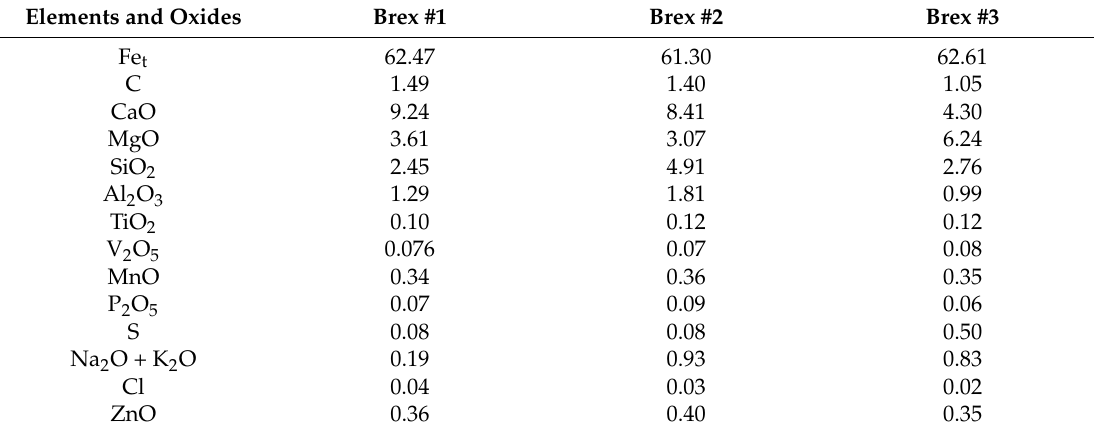
Table 3. Chemical composition of experimental brex before reduction,